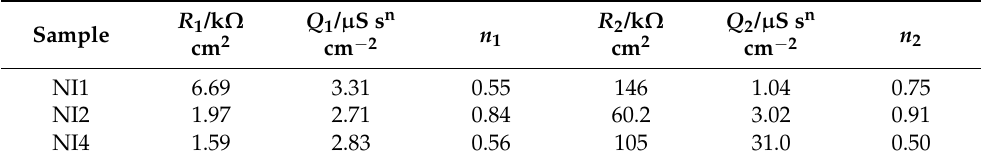
Table 5. EIS parameters obtained by fitting impedance data in Figure